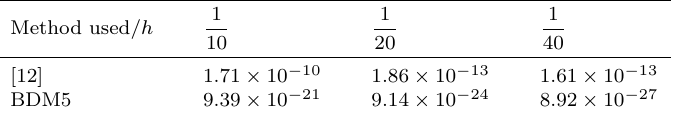
Table 3. Comparison of maximum absolute errors (MAE) on Example 1. Method used/ h